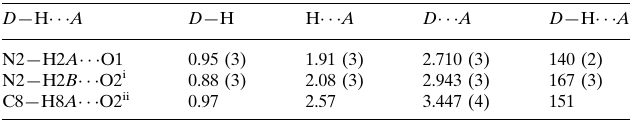
Hydrogen-bond geometry (A˚ , (cid:4)